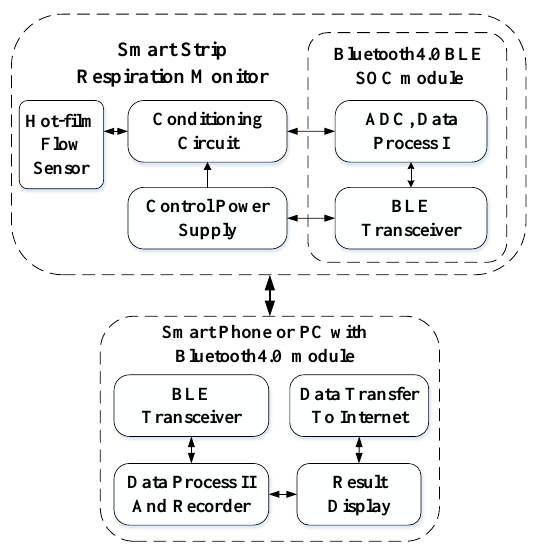
Figure 2. The block diagram of signal flow.